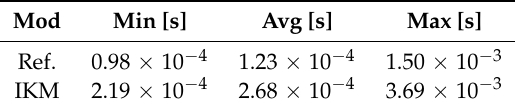
Table 7. Computation Times of the hexapod’s IKM and its reference model (“Ref.” row), for all the points in the predetermined trajectory. Column “Avg [s]” presents the average computation times obtained during the trajectory’s execution (in seconds), while “Min [s]” and “Max [s]” show the minimum and maximum registered times,